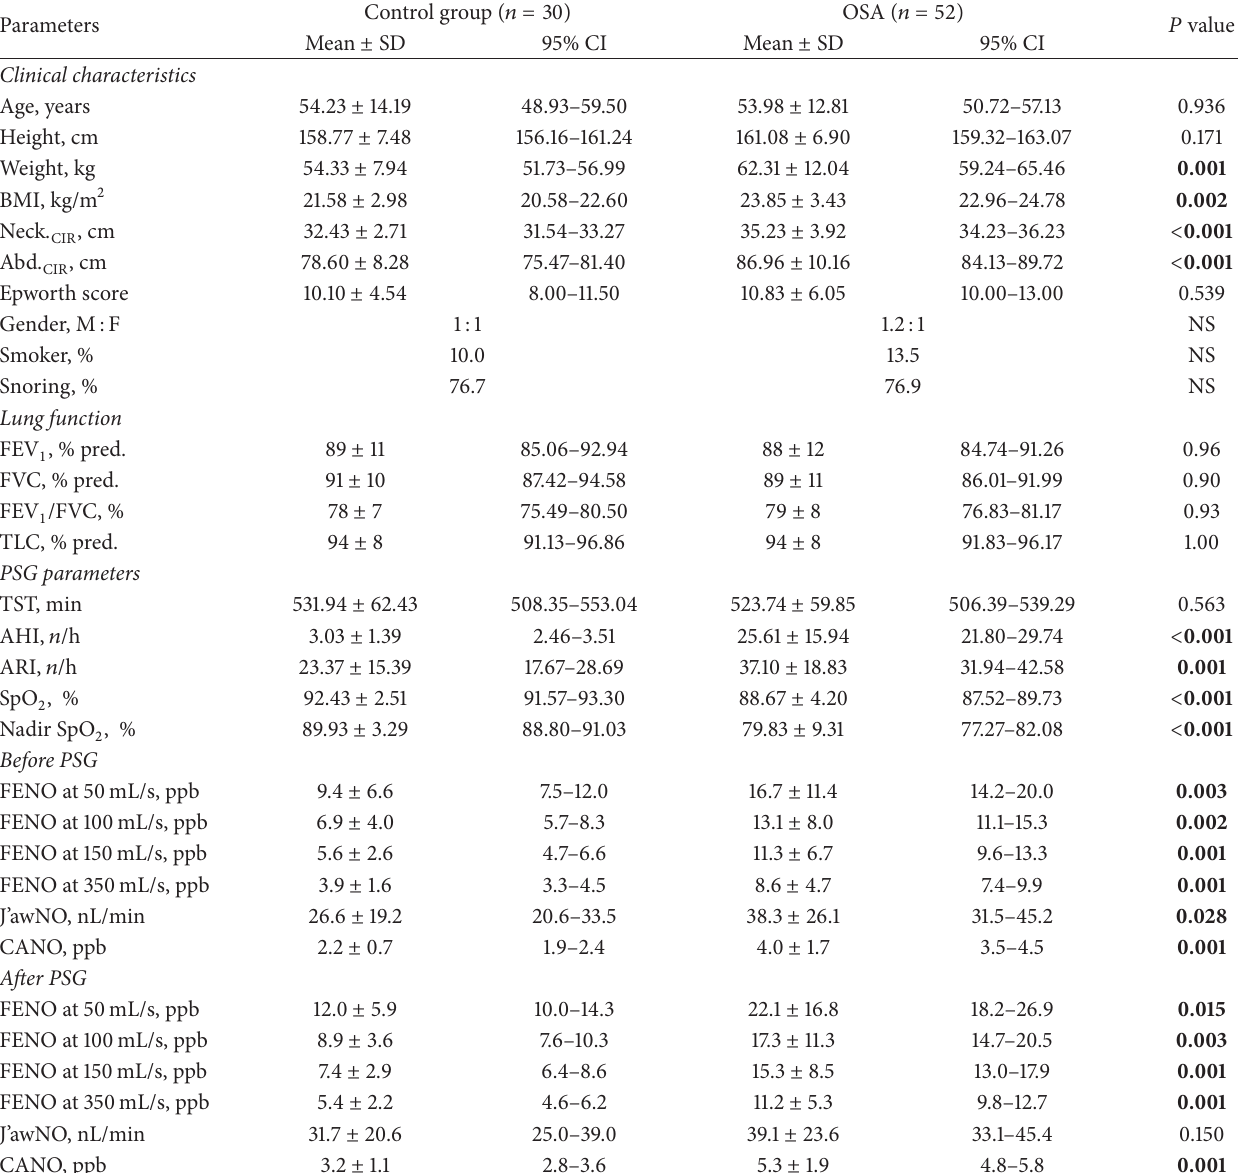
Table 1: Clinical and functional characteristics of study